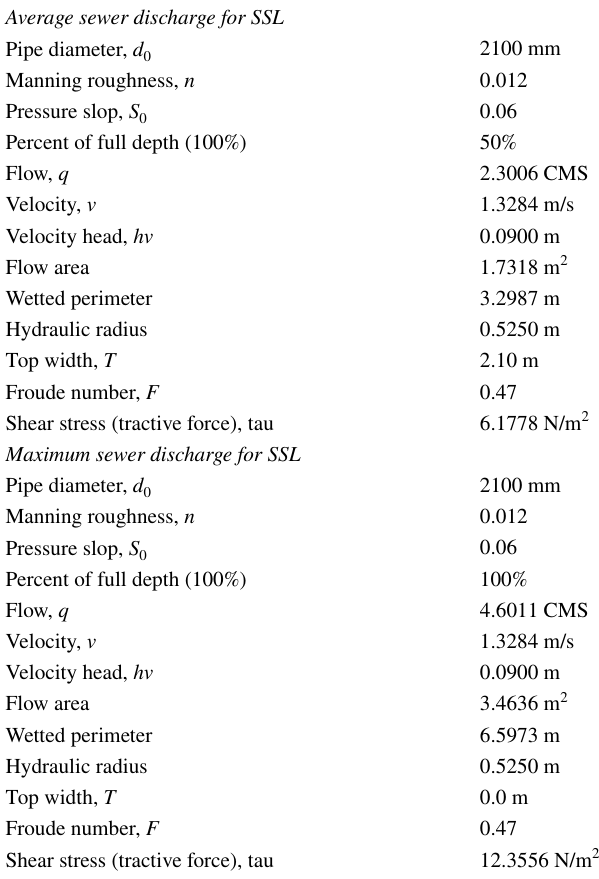
Table 3 (a) Average and (b) Maximum sewer discharge for SSL Average sewer discharge for